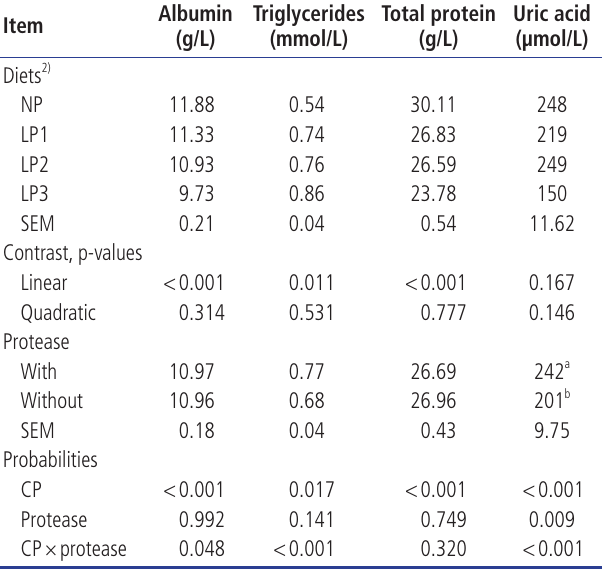
Table 5. Effect of crude protein level and protease enzyme supplementation on carcass traits (as % of live weight) in broiler chickens at 36 days of age